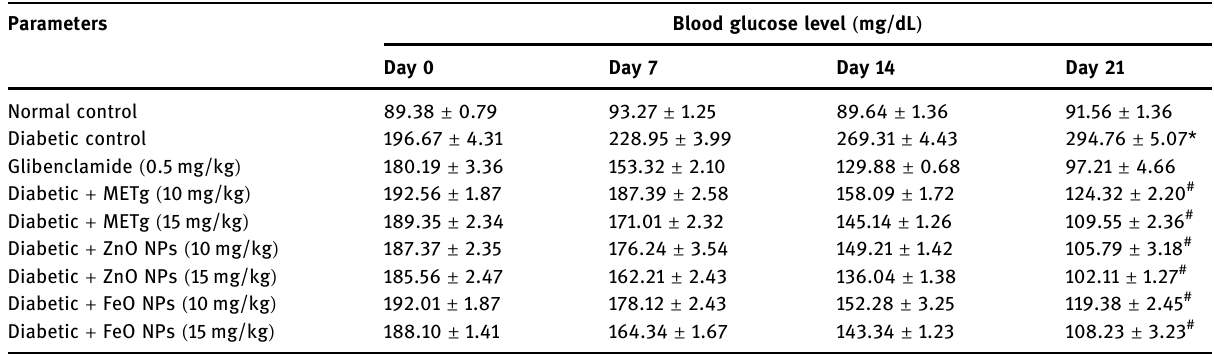
Table 1: E ff ect of T. glabra methanolic extract, and their mediated ZnO NPs and Fe 2 O 3 NPs on blood glucose in experimental animals Parameters